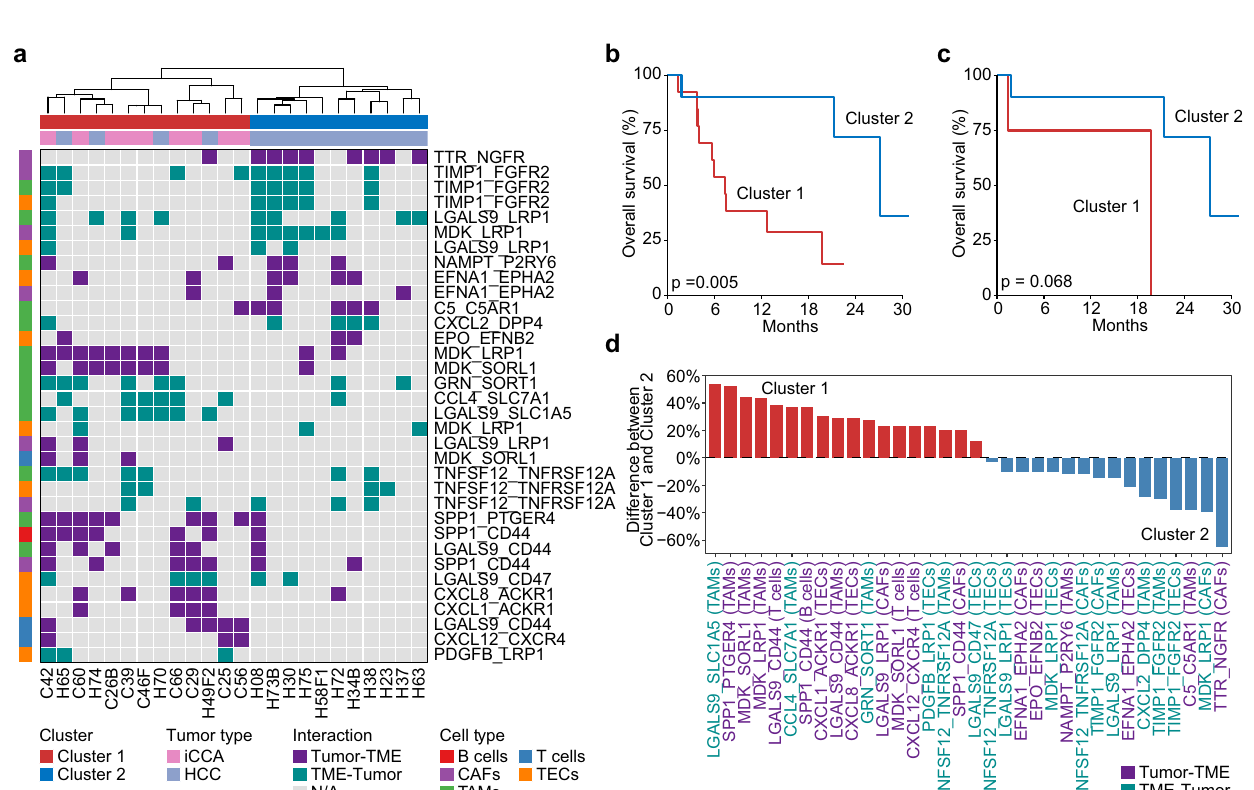
Fig. 4 | Communication of malignant cells and non-malignant cells. a Ligand – receptor interactions of malignant cells and non-malignant cells in six cases with viable malignant cells. Each column indicates a ligand – receptor pair, with the fi rst and the second gene representing a ligand and a receptor, respec- tively. Each row represents a non-malignant cell type that interacts with malignant cells. The directionofaninteraction isindicatedby colored dot. Purple, malignant cells provide ligands and interact with receptors from non-malignant cells in the TME; green, non-malignant cells in the TME provide ligands and interact with receptors from malignant cells. The size of each dot represents the proportion of tumor regions within each case in identifying a speci fi c interaction pair, with 1 indicating occurrence in all tumor regions and 0 indicating occurrence in none of the tumor regions. b Illustration of ligand – receptor interactions of tumor and the TME.Purpledots,ligandsfromtumor;greendots,ligandsfromTME. c Stackedbar plot of the percentage of ligand – receptor pairs in each individual case found in